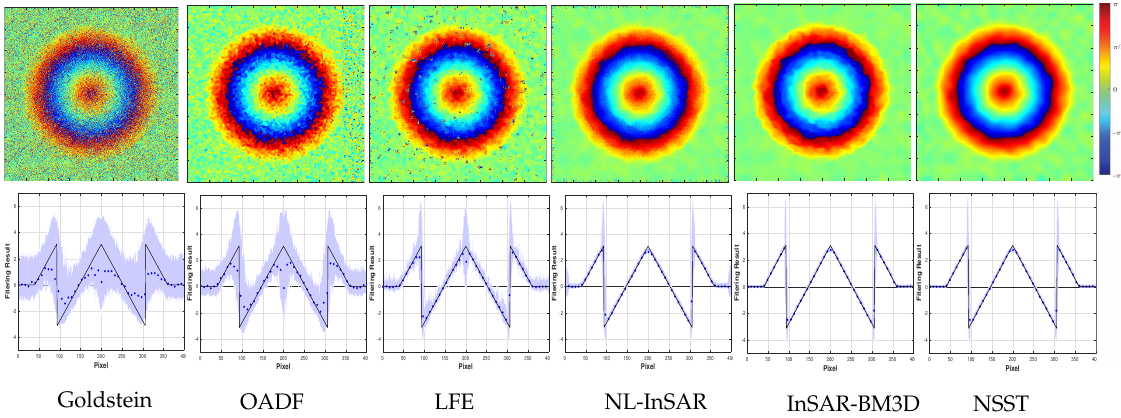
Figure 7. Clean interferograms and noisy interferograms generated by a cone with coherence of 0.5.